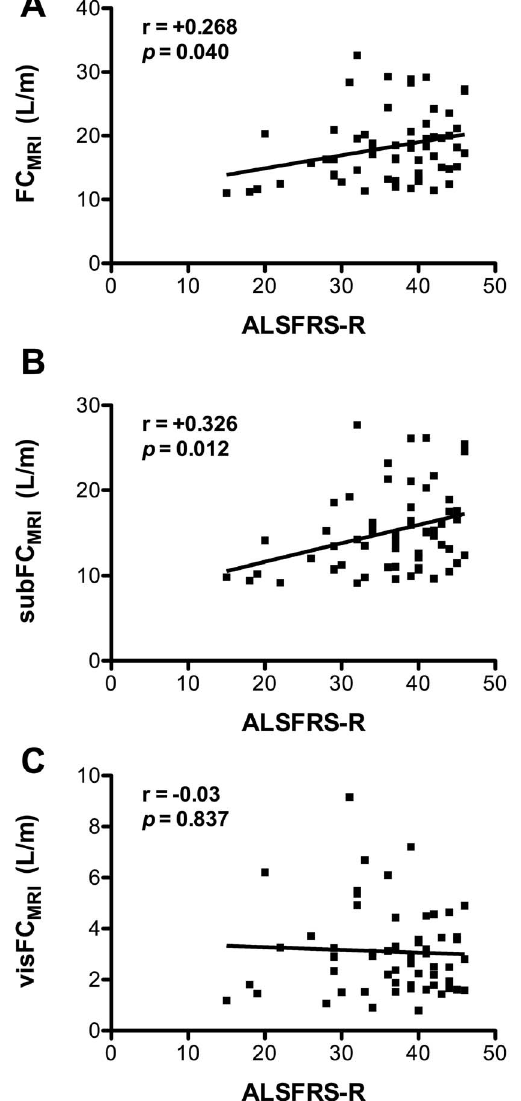
Figure 3. Subcutaneous fat content correlates with functional status of ALS patients. Correlations among Total (FC MRI , A), subcutaneous (subFC MRI , B), visceral (visFC MRI , C) fat content in MRI scans and amyotrophic lateral sclerosis functional rating scale scores (ALS-FRS-R). p values and the corresponding correlation coefficients ( r ) are indicated. If the correlation coefficient is positive, the two variables Figure 4. Subcutaneous fat content correlates with disease tend to increase or decrease together. progression of ALS patients. Correlations among total (FC MRI , A), doi:10.1371/journal.pone.0067783.g003 subcutaneous (subFC MRI , B), visceral (visFC MRI , C) fat content in MRI scans and slopes of amyotrophic lateral sclerosis functional rating scale scores (ALS-FRS-R, in points per month). p values and the corresponding score (i.e., 48) – ALS-FRS score at MRI)/disease duration correlation coefficients ( r ) are indicated. If the correlation coefficient is correlated significantly with FC MRI (r =0.266, p =0.048, positive, the two variables tend to increase or decrease together. Figure 4A ). This was due to subcutaneous fat since subFC MRI doi:10.1371/journal.pone.0067783.g004 correlated significantly with disease progression (r =0.311, p = 0.01, Figure 4B ), in contrast to visFC MRI (r =0.05, visFC MRI and subFC MRI including gender, age, site of onset and p = 0.720, Figure 4C ). It should however be noted that disease ALS-FRS-R. In these models, gender and ALS-FRS-R but not age progression was very homogenous across patients, with most or site of onset significantly attached to FC MRI and subFC MRI . patients losing less than 1 point of ALS-FRS-R score per month. Gender, but not age, site of onset or ALS-FRS-R significantly Fat distribution is likely to be modified by multiple factors, attached to visFC MRI ( Table 2 ). Thus, functional status and including gender, age, or MND-specific factors. We constructed a disease progression of ALS patients correlated positively with 4 subcutaneous fat. At the time of closure of our study (01/12/ x i for FC b multiple linear regression model y ~ b 0 z P MRI , i 2012), 34 ALS patients had died and 23 were still alive. We had no i ~ 1 PLOS ONE |